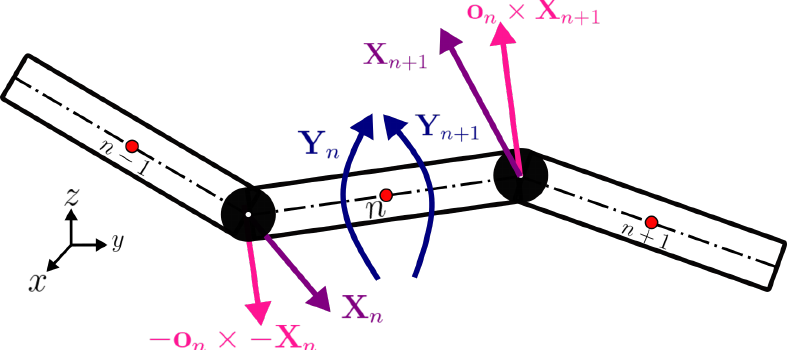
Figure 4. Schematic representation of three constrained, pointwise rod elements with the constraint forces and